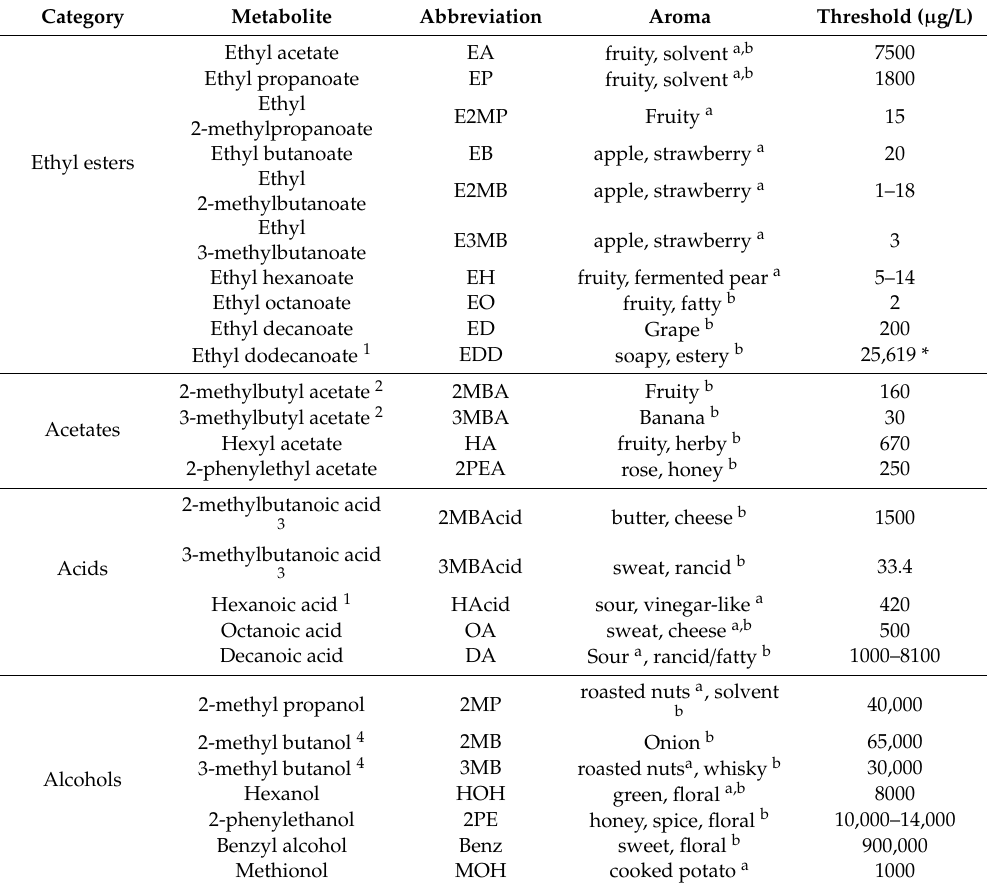
Table 1. List of yeast-derived secondary metabolites measured, as well as their characteristic aromas and odour detection thresholds in 10% ( v / v ) ethanol ([39–44], compiled by